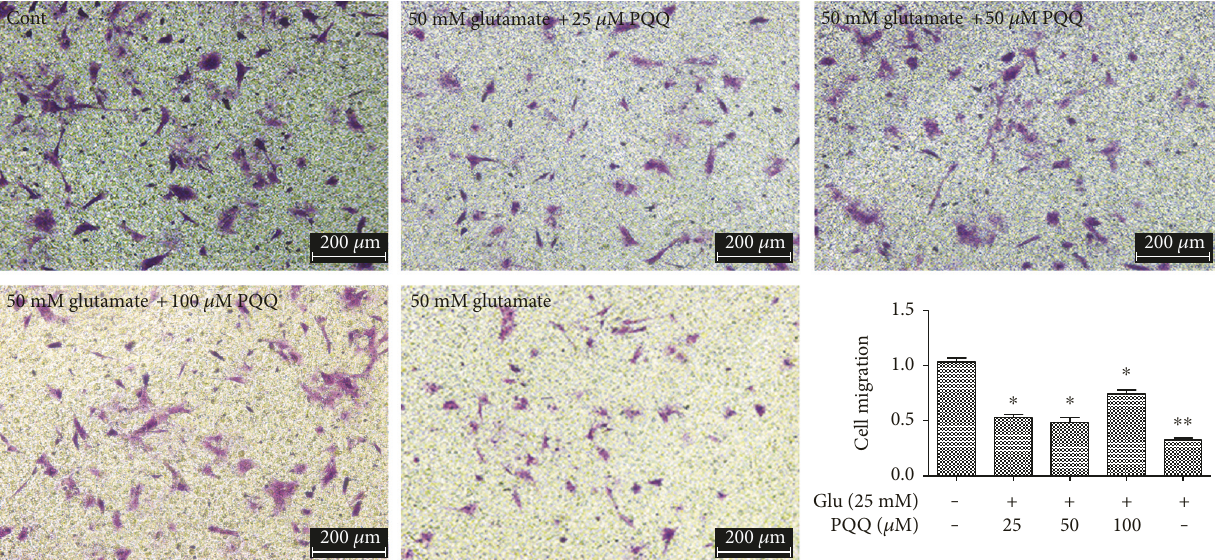
Figure 16: The migration of astrocytes after glutamate and PQQ ( ∗ P < 0 05 , ∗∗ P < 0 01